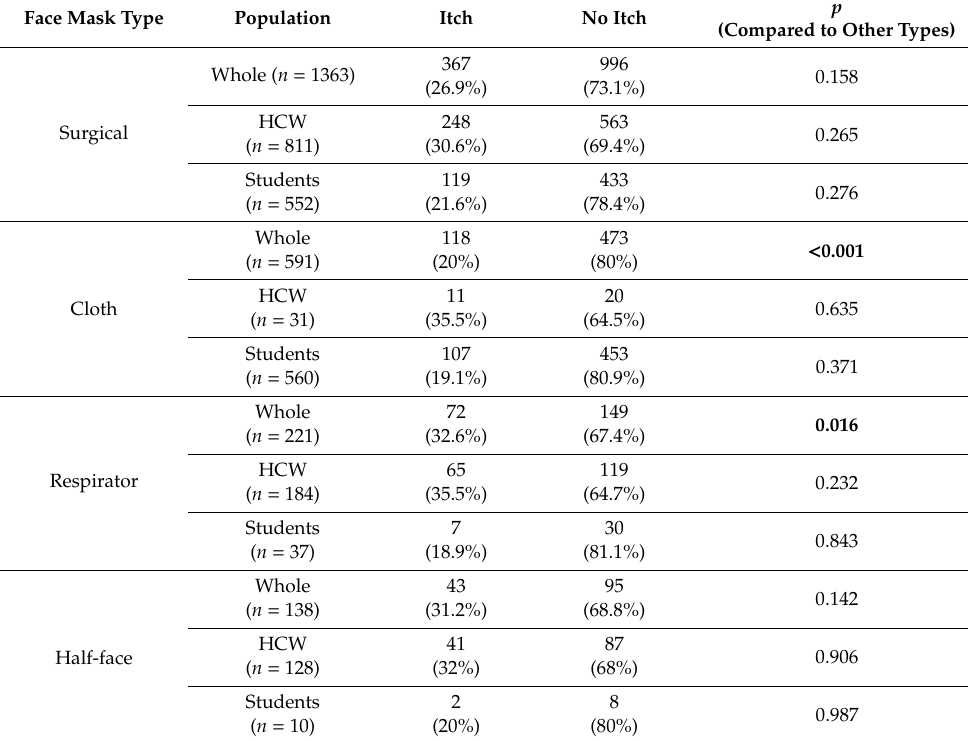
Table 5. Prevalence di ff erence according to face mask